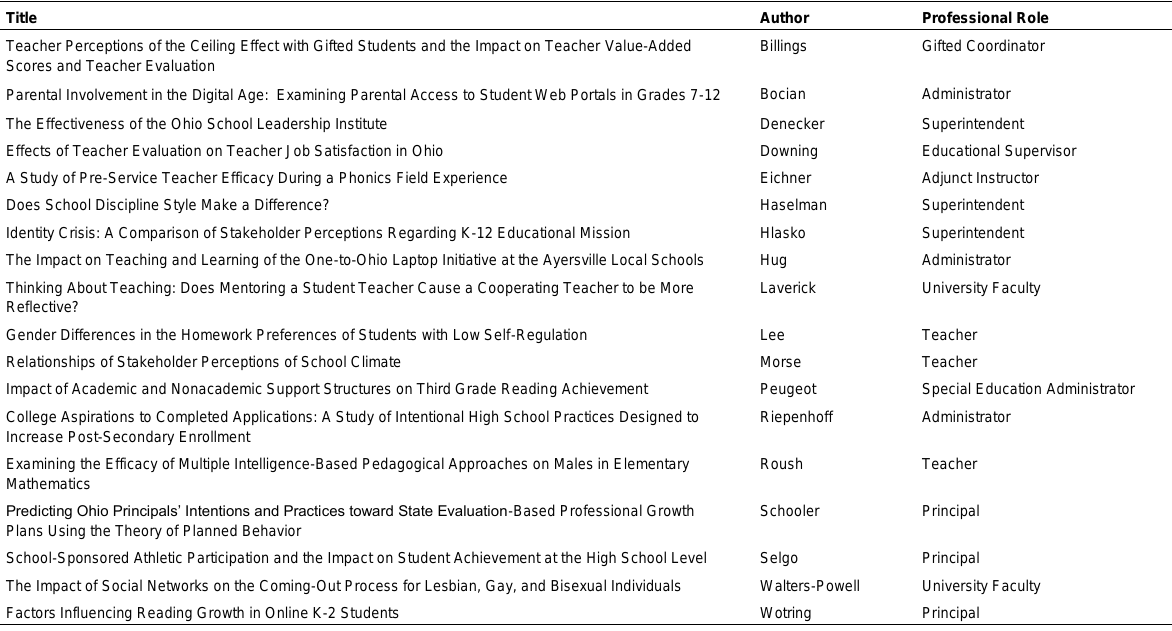
Table 1: Dissertation Title, Author, and Author Professional